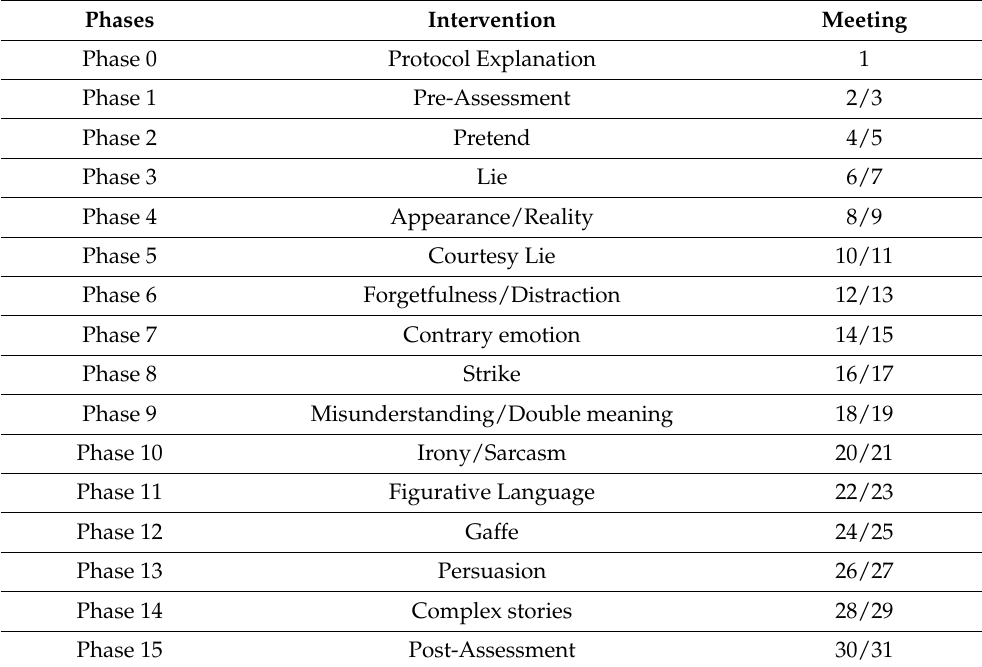
Table 3. Protocol